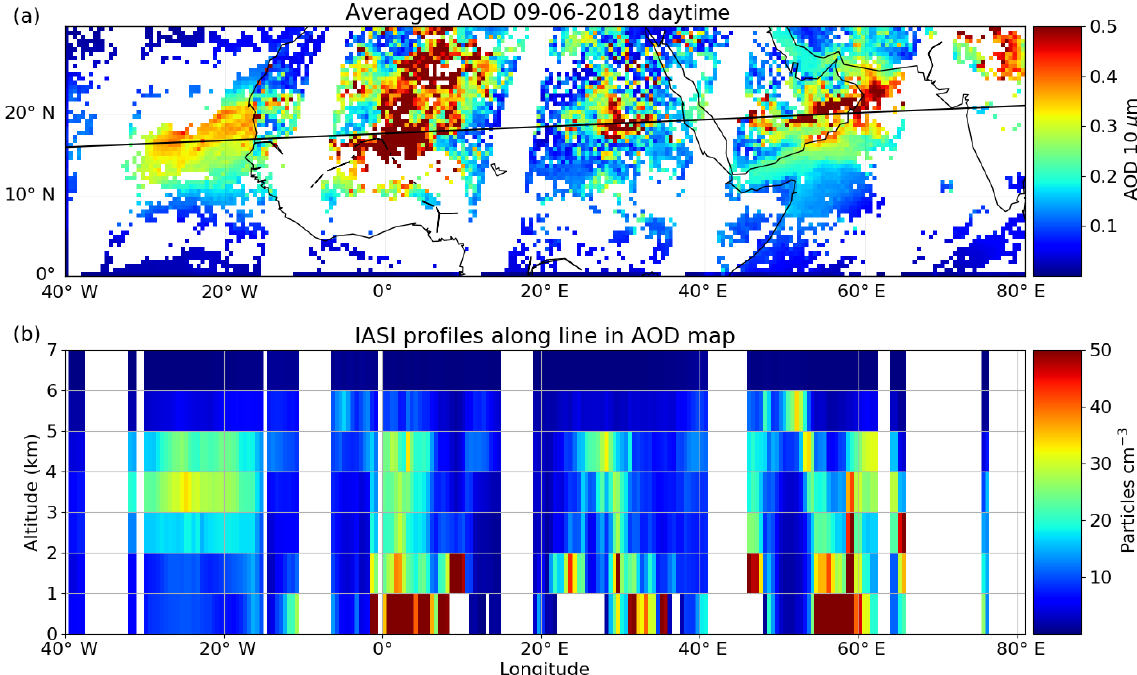
Figure 4. Cross section of MAPIR dust profiles on 9 June 2018. The first plot gives a map of the retrieved daytime 10µm AOD on a 0 . 5 ◦ by 0 . 5 ◦ grid over the region we are interested in. The black line represents the locations along which the cross section in the second plot is given. Each profile of the cross section is an average of all profiles within 0 . 5 ◦ of the transect